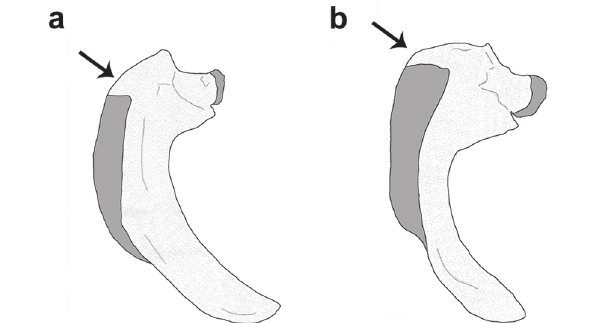
Fig. 4. Inverted lateral view, of the right maxilla of (a) Eigenmannia sp. “A” (MPEG 27061, 111.8 mm LEA) and (b) Eigenmannia sp. “B” (MPEG 27066, 117.6 mm LEA). Arrow indicates antero-dorsal process. Scale bar of 1 mm.